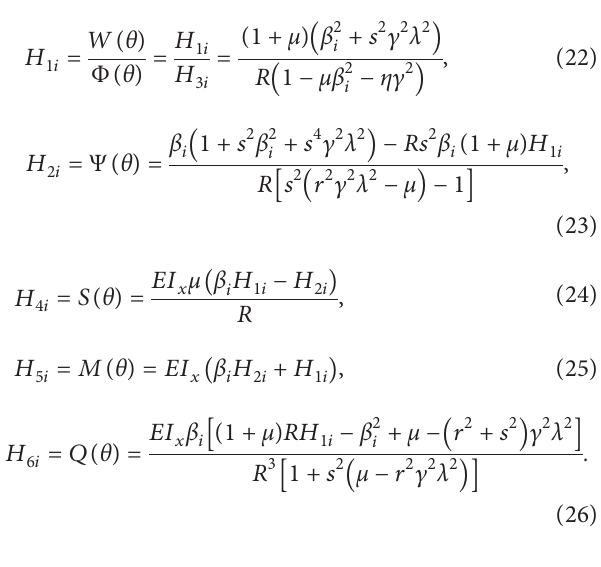
wavenumber and imaginary wavenumber motion behaviors of the frequency spectrum for the curved beam model. Figure 2 indicates that these waves divide the frequency spectrum into four regions while the wave propagates in this model, namely, region I, region II, region III, and region IV. There are three bifurcation points f a , f b and f c . It can then be ob- , served that these bifurcation points play an important role in determining the wave motion behavior. Here, the value of cut-off ��� 􏽰 E / ρ frequency can be calculated as f c � ( c depicted in Figure 2. At this frequency, the circumference of the curved beam happens to hold a radial wavelength, and it is called the ring frequency